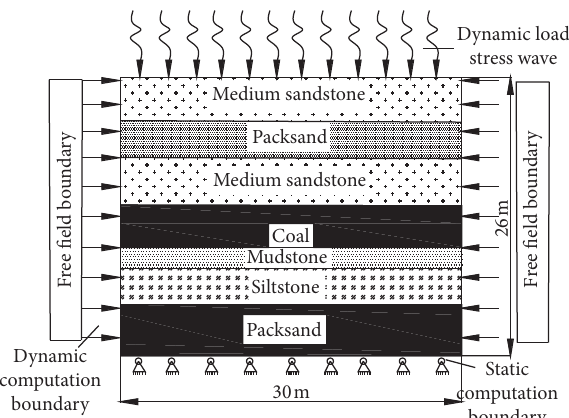
Figure 6: Model schematic